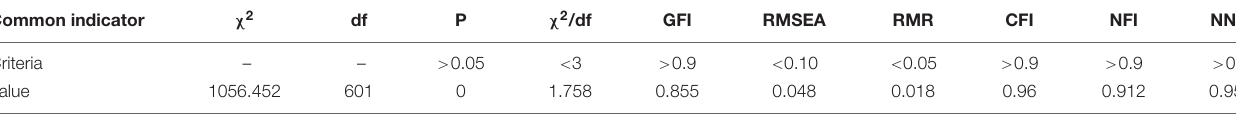
TABLE 5 | Model fitting indicators.